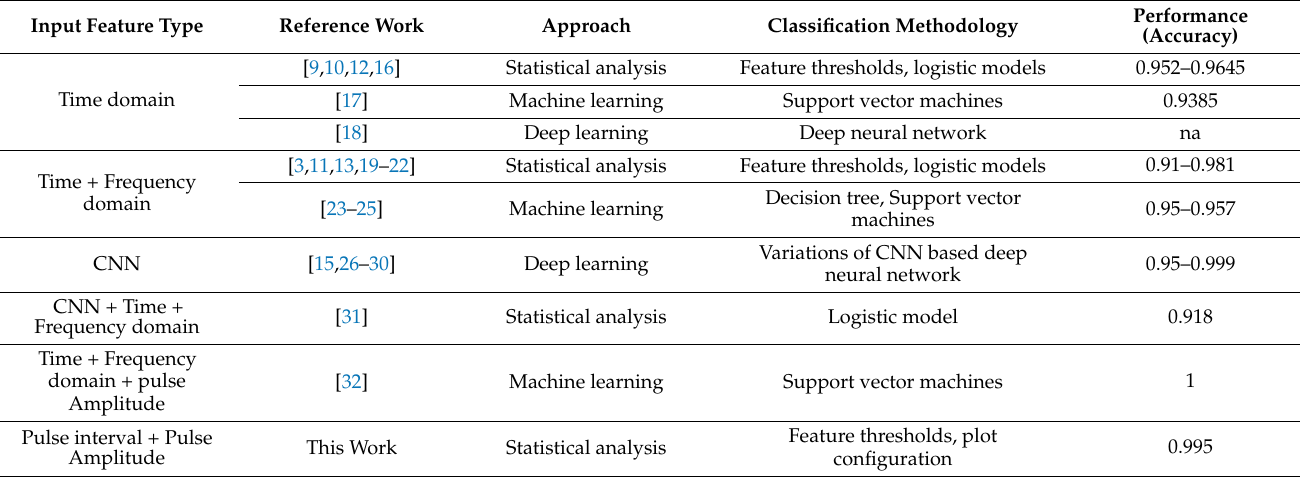
Table 1. Features and methodology used in previous studies compare to this